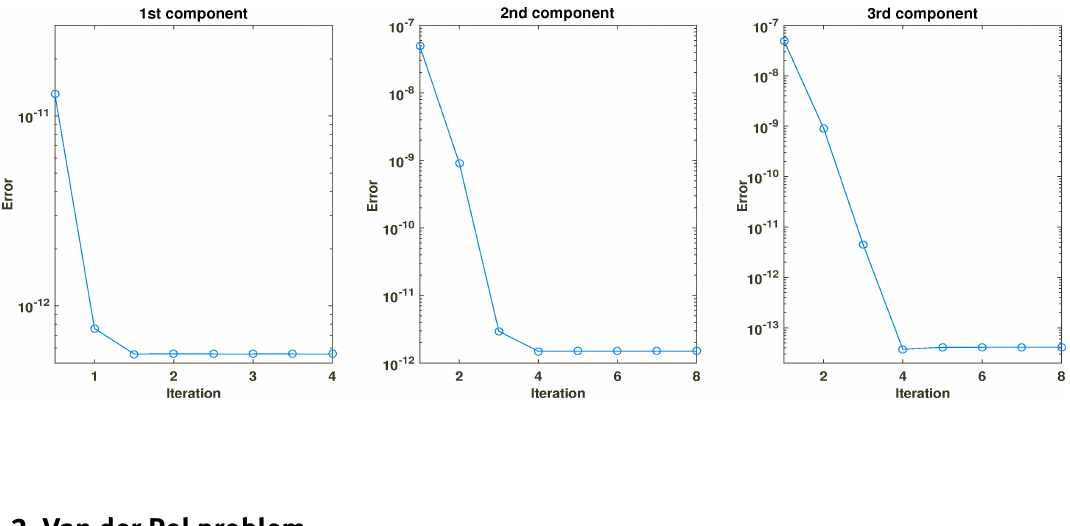
Fig. 2. Convergence behavior of parareal iterations for each component of the given